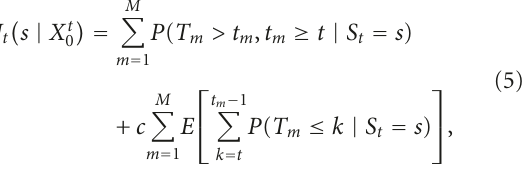
closed channels, and M − m is the number of possible selections of channels being